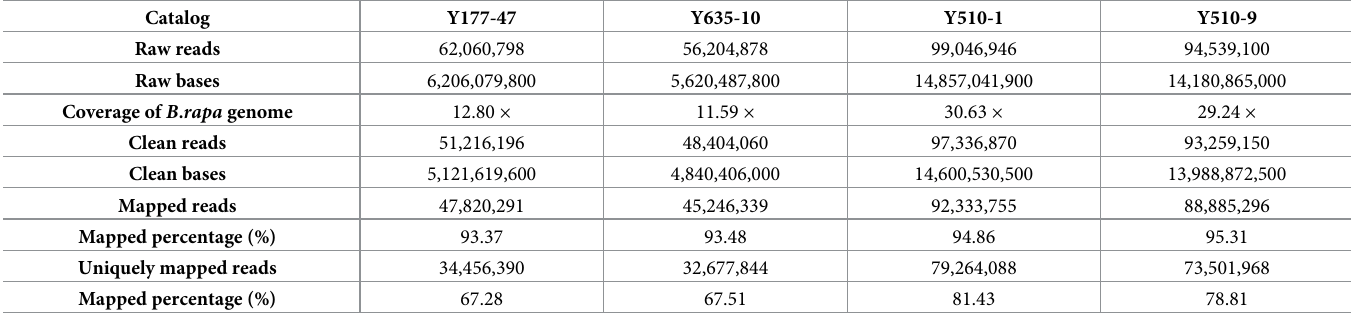
Table 1. Summary of whole-genome re-sequencing data of four Chinese cabbage DH